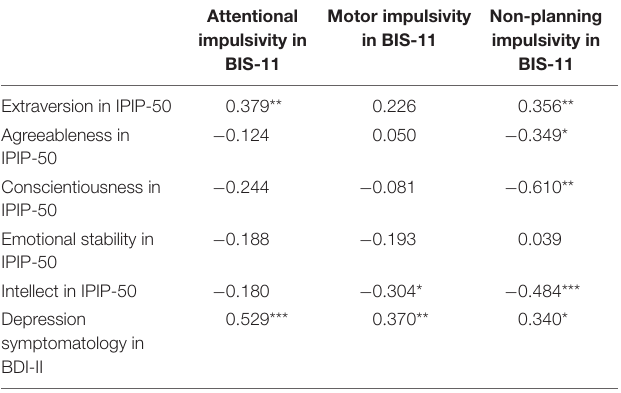
TABLE 2 | Pearson correlation coefficients for the relation of personality traits and depression symptomatology with impulsivity.